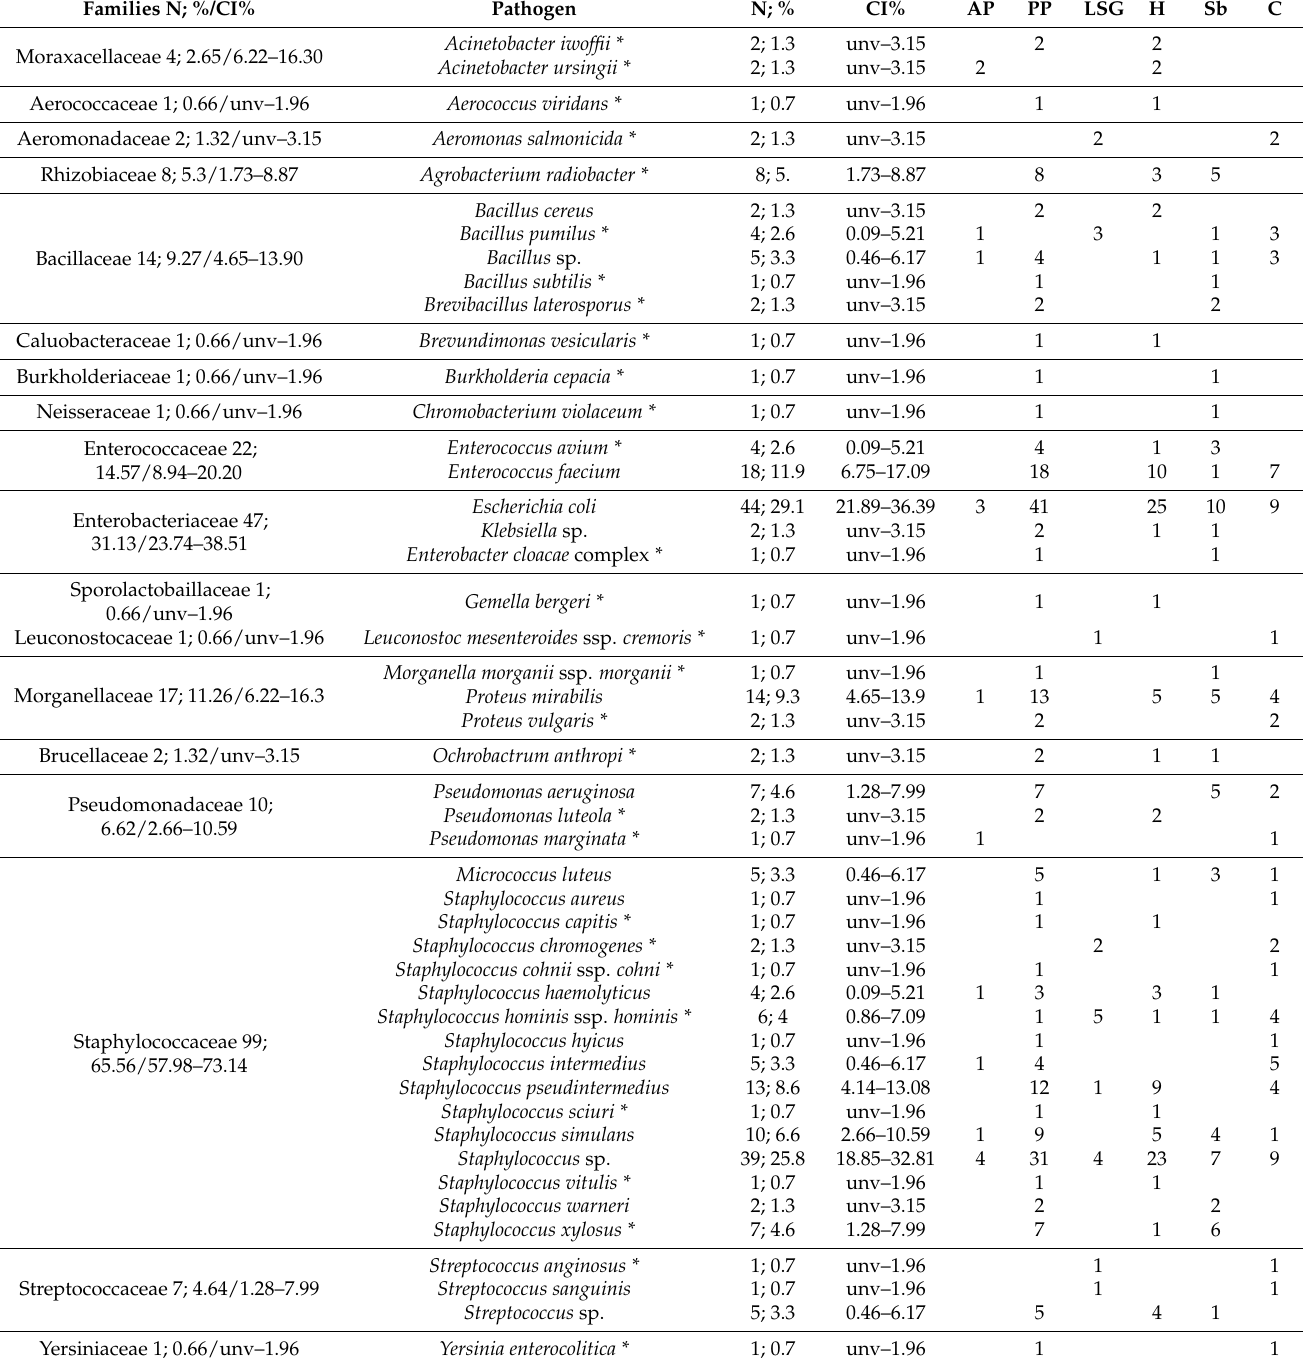
Table 1. Bacterial species isolated from milk samples. Confidence intervals at 95% (CI) were calculated using the formula for